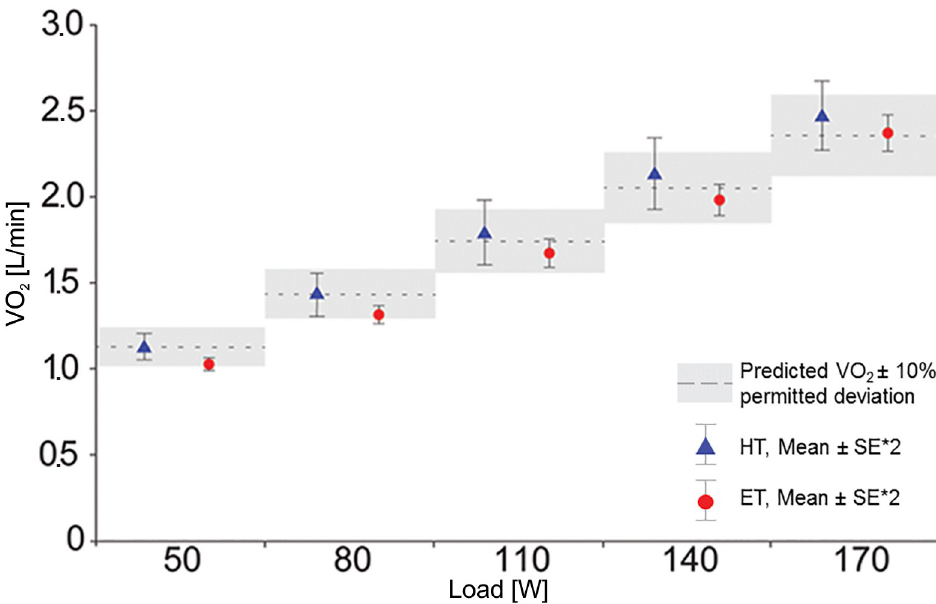
Fig 3. Comparison between HT and ET at FIO 2 = 39.85%. The dotted lines represent the _ VO man according to Wasserman et al. (2012). The grey block around the dotted line represents the permitted Deviation of ± 10% (see Table 2). The mean values of HT and ET at each load-level are shown with the double standard error to confidence of the plausibility of _ VO predicted. Abbreviations: HT Haldane Transformation, ET Eschenbacher 2 Transformation.